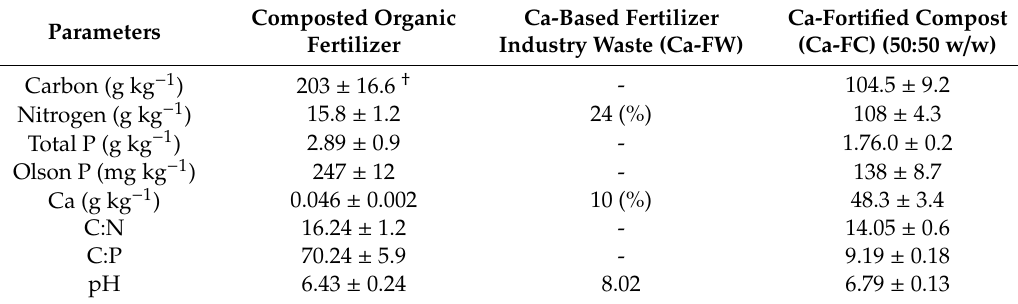
Table 3. The chemical analysis of normal compost and